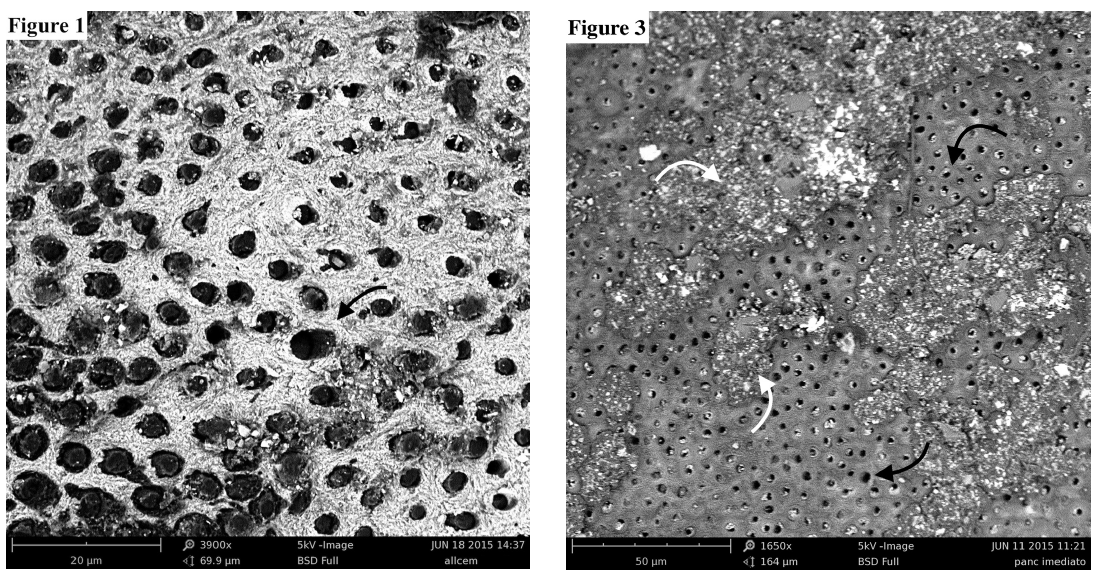
Figure 3 – (Magnification: 1650x – Scale bar: 50µm) - Representative SEM image of fractured specimen from Panavia F group (dentin side). Is possible to observe some empty dentin tubules and others with resin cement remnants was detected (black arrows). White arrows: layer of resin cement.